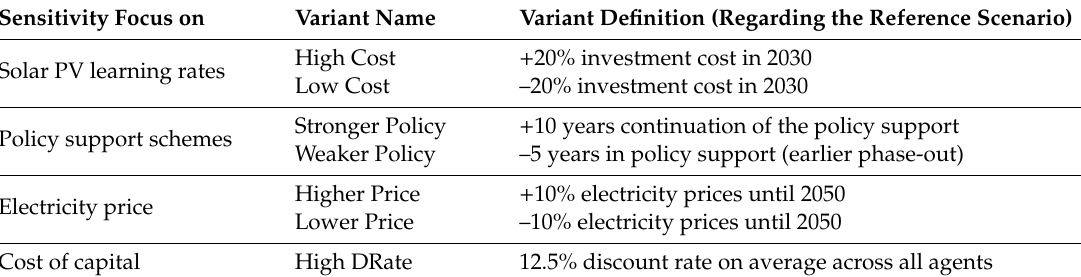
Table 3. Overview of the assessed variants of the Reference